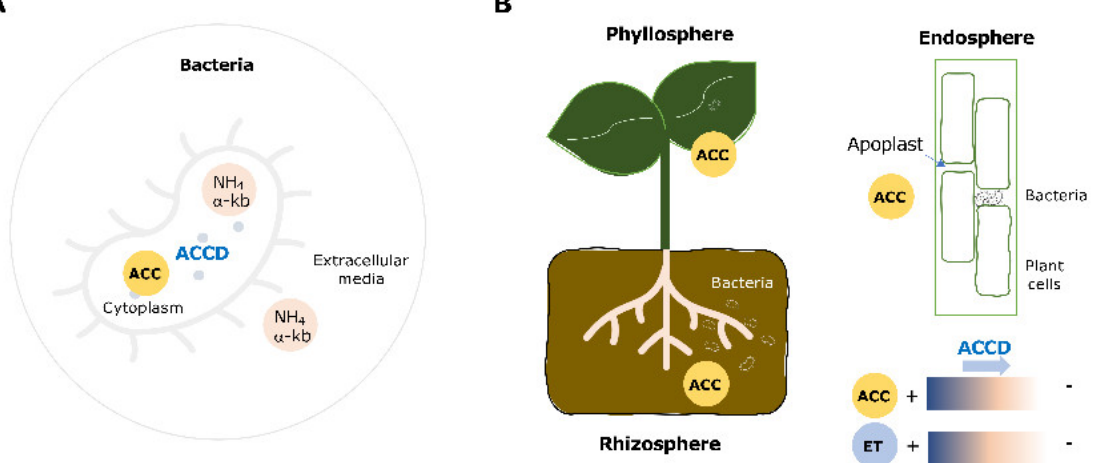
Figure 1. Schematic representation of ( A ) bacterial 1-aminocylopropane-1-carboxylate (ACC) deaminase activity and ( B ) the modulation of plant ACC and ethylene concentrations. ACC-1-aminocyclopropane-1-carboxylate; ET-ethylene; ACCD ‐ ACC deaminase.